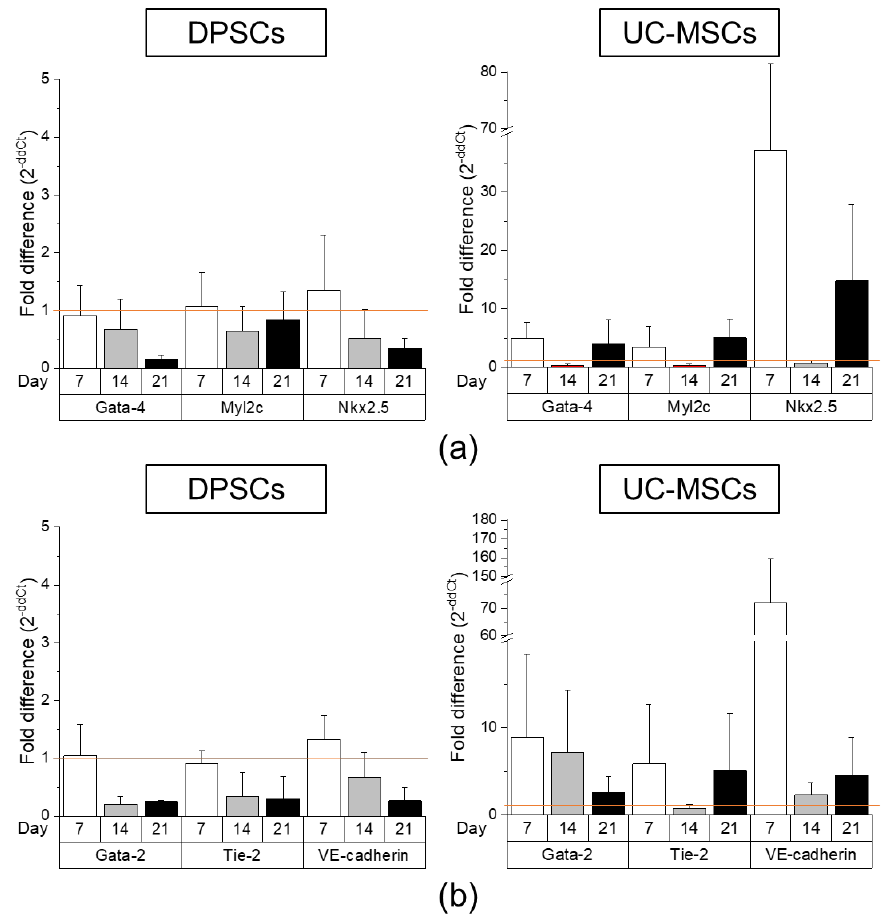
Figure 5. Comparison of cardiomyogenic and endothelial differentiation potential of DPSCs and UC-MSCs by Real-Time PCR. ( a ) Quantitative analysis of mRNA expression of cardiomyogenesis related genes ( Gata-4, Nkx2.5, Myl2c ) in DPSCs (left) and UC-MSCs (right). Cells were cultured in DMEM/F12 supplemented with 2% FBS and 10 ng/mL basic fibroblast growth factor (bFGF), 10 ng/mL vascular endothelial growth factor (VEGF) and 10 ng/mL transforming growth factor β1 (TGF-β1) for 7, 14 and 21 days. ( b ) Quantitative analysis of mRNA expression for endothelial related genes ( Gata-2, Tie-2 , VE-cadherin) in DPSCs (left) and UC-MSCs (right). Cells were cultured in EGM-2MV endothelial cell growth medium for 7, 14 and 21 days. Fold differences in the expression (2 −ddCt ) of analysed genes in control cells cultured in standard cell culture medium (undifferentiated) were calculated as 1.0 and marked by a solid line. Graphs present different scales. Results are presented as mean ± SEM, n = 3 (every sample prepared for each DPSCs line from each donor was run in duplicate); t -test, p < 0.05 vs. undifferentiated cells.